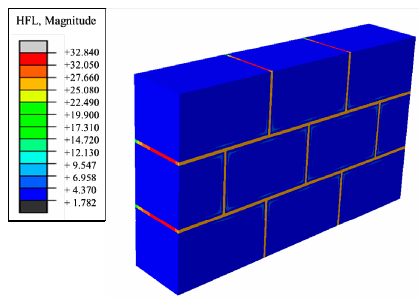
Figure 4. Heat flux nephograms of steady heat transfer.